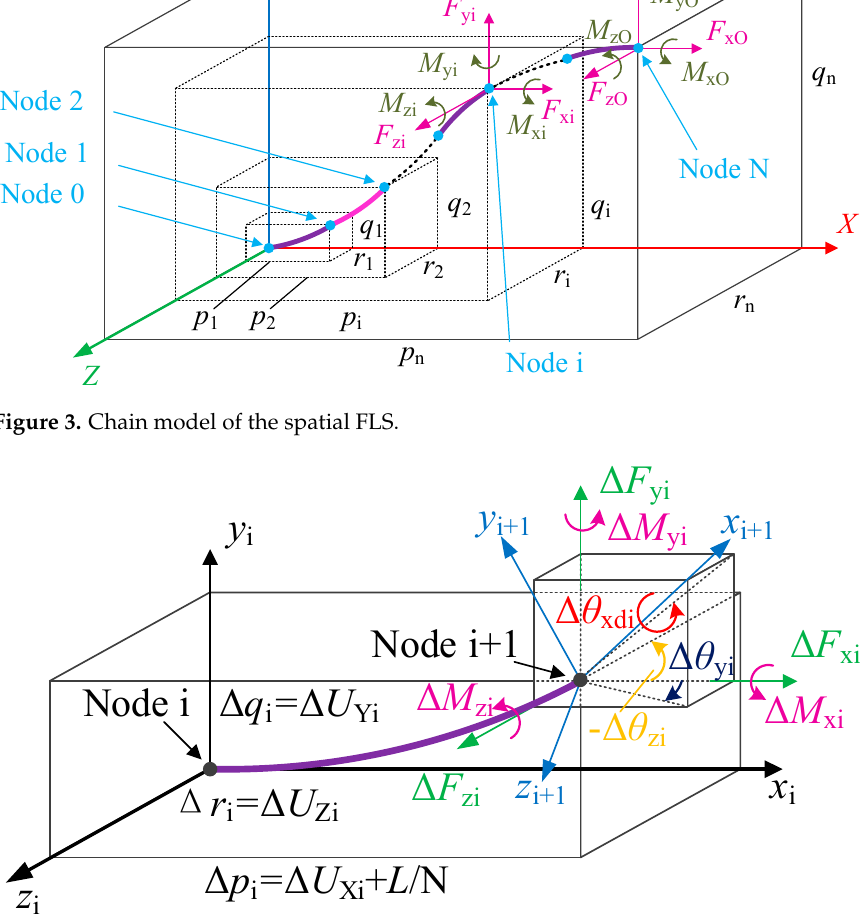
Figure 4. Loads and coordinate transformation of a spatial flexure element. The transformation matrix between the local coordinate system x i - y i - z i of the i-th ele- ment and the global coordinate system X - Y - Z is as follows: